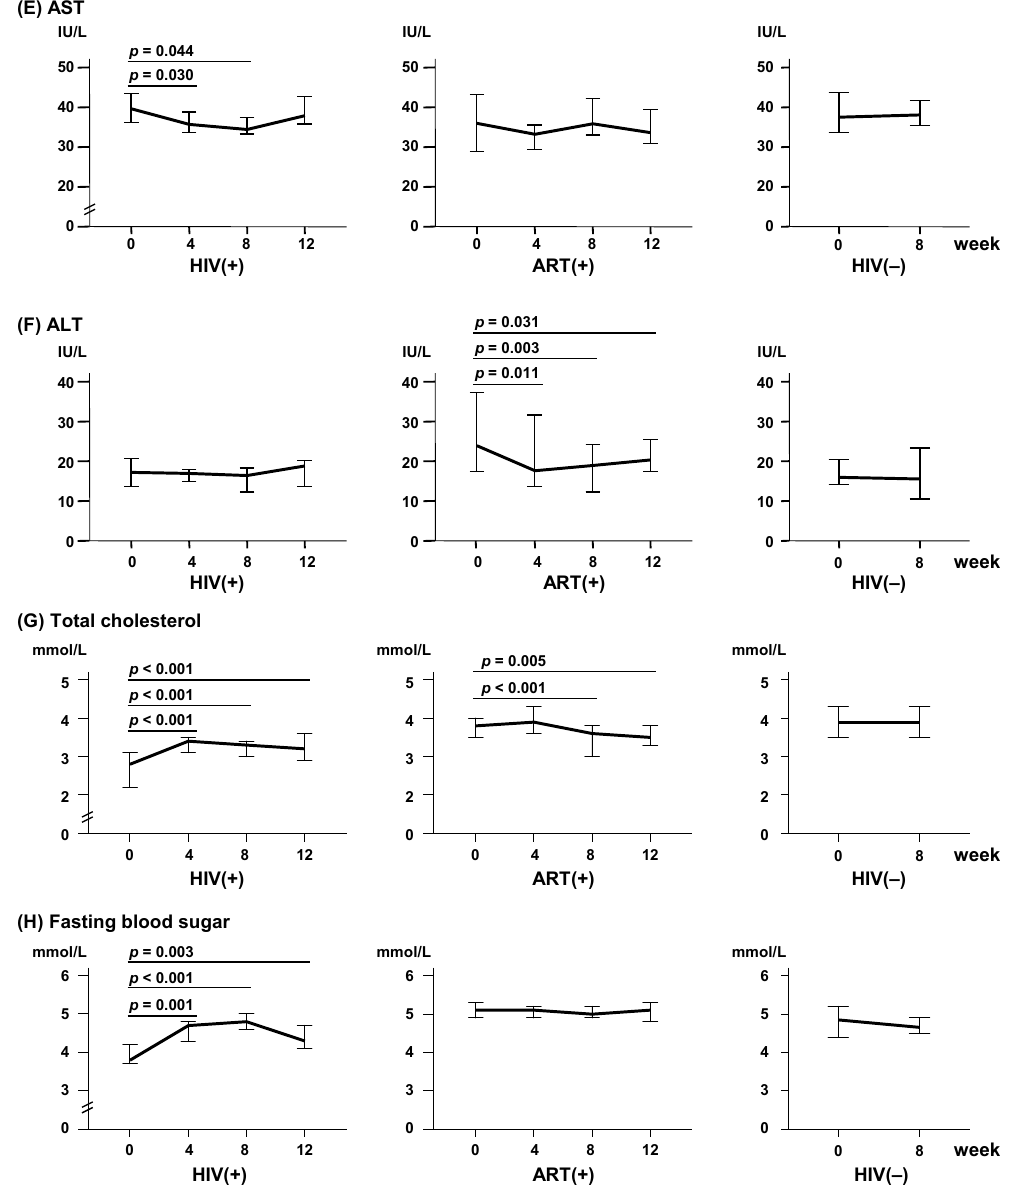
Figure 1. Changes of physical and clinical parameters after Lactobacillus casei Shirota (LcS) ingestion in the HIV(+) ( n = 31), ART(+) ( n = 29), and HIV( − ) ( n = 20) groups. ( A ) Height; ( B ) Body weight; ( C ) Hemoglobin; ( D ) Platelet counts; ( E ) Aspartate aminotransferase (AST; normal range: < 40 U/L); ( F ) Alanine aminotransferase (ALT; normal range: < 40 U/L); ( G ) Total cholesterol (normal range: 3.9–5.2 mmol/L); ( H ) Fasting blood sugar (normal range: 4.2–5.5 mmol/L). Bars represent the median and 95% confidential interval (CI) for each group. The p values show the comparison of weeks 4, 8, and 12 to week 0. HIV: Human immunodeficiency virus type 1; ART: Antiretroviral therapy. 2.3. LcS Ingestion Increased CD4 + Cells, Especially Th2 and Th17 Subsets